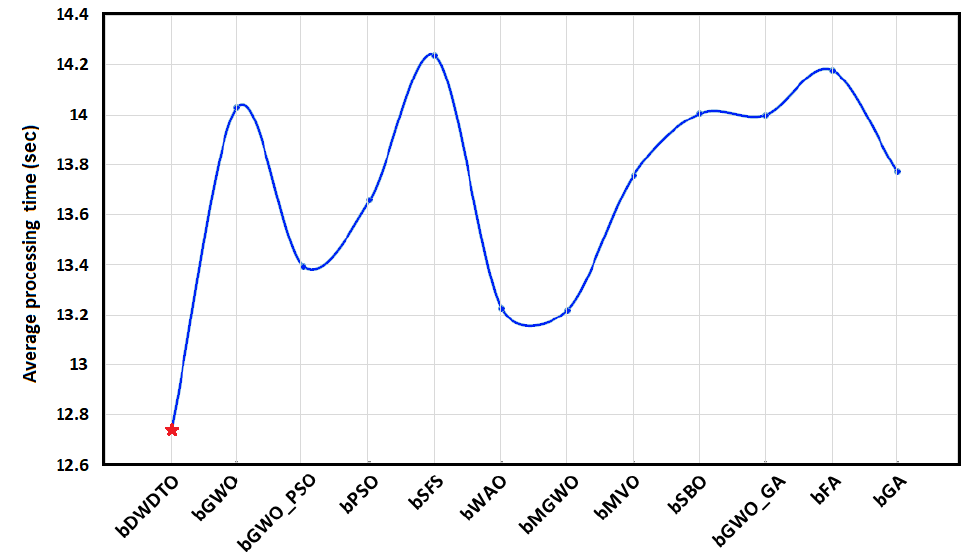
Figure 10. Average processing time (in seconds) using the proposed optimization algorithm and the other competing optimization algorithms. The red star refers to the minimum average processing time which is achieved by the proposed bDWDTO algorithm.